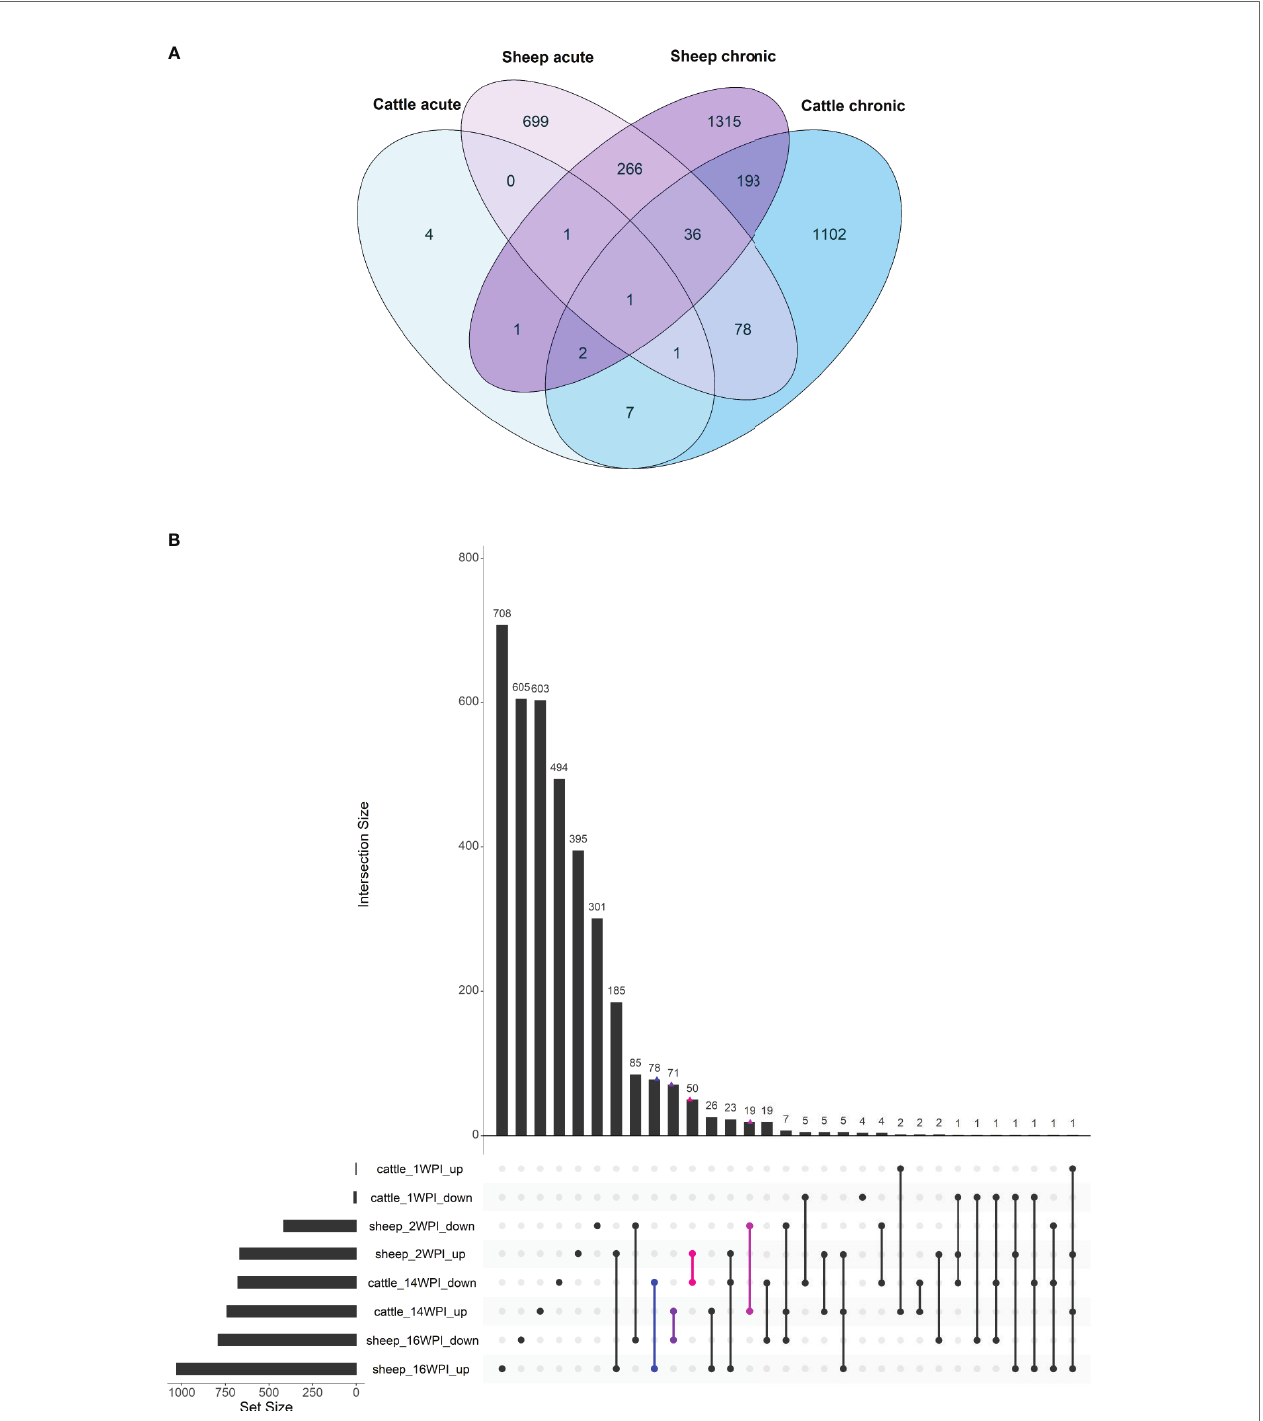
FIGURE 6 | Overlap of genes from the longitudinal analysis of cattle and sheep response to infection with F. hepatica between the acute and the chronic phase depicted by a Venn diagram (A) and an UpSet plot where the overlaps between up- and downregulated genes are shown in both sheep and cattle at all time points (B) . On the UpSet plot, overlaps where up-regulated genes are the same as downregulated genes in another species are indicated in colour (blue, purple – DE genes with opposite direction of expression in sheep and cattle chronic phase; pink, magenta - DE genes with opposite direction of expression in acute phase in sheep and chronic phase in